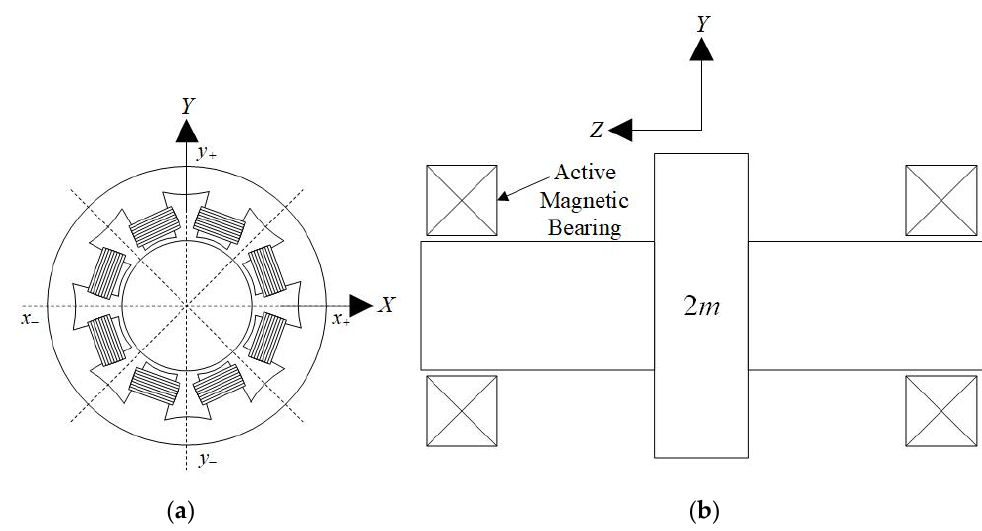
Figure 1. ( a ) Schematic of an active magnetic bearing. ( b ) Schematic of a rigid rotor supported by two active magnetic bearings.